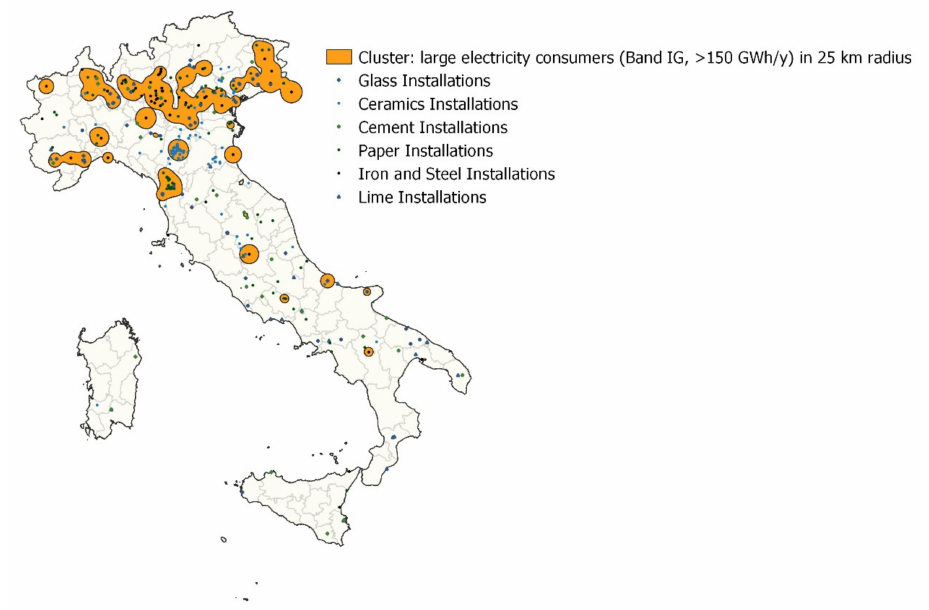
Figure 7. Clusters of industrial installations based on electricity